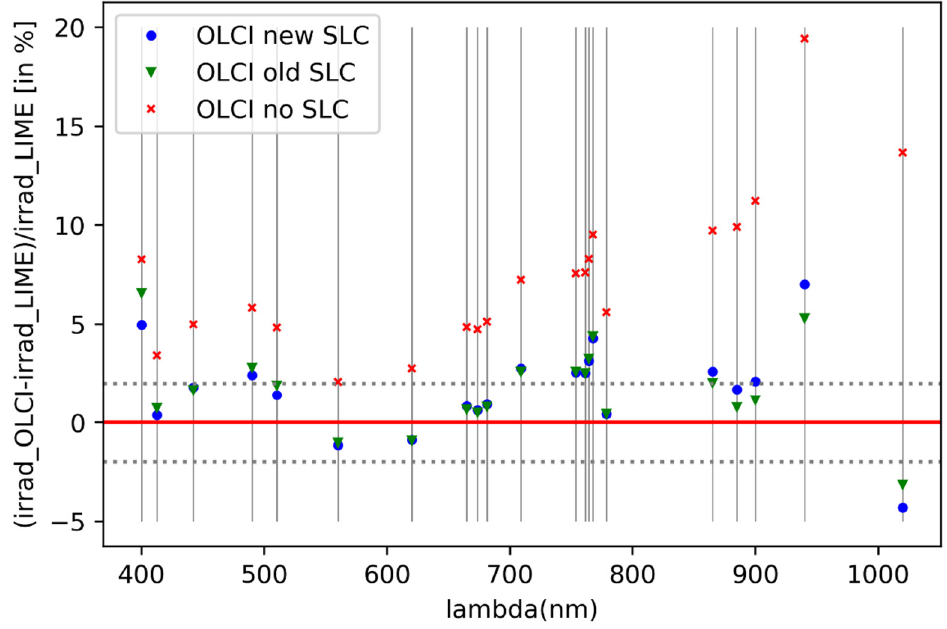
Figure 15. Comparison of OLCI calculated irradiances (with di ff erent SLC) relative to the LIME model.